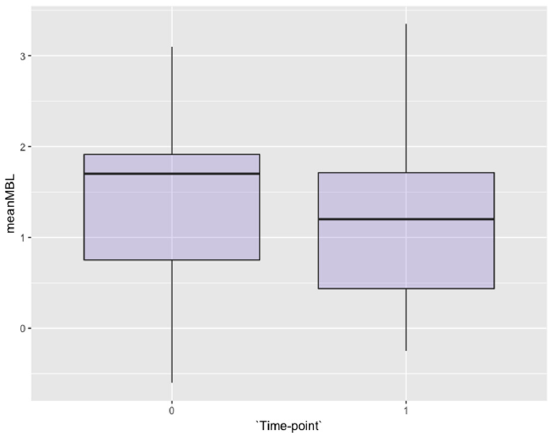
Figure 2. Box-plot of the mean marginal bone levels at the baseline and one year after loading. J. Clin. Med. 2019 , 8 , x FOR PEER REVIEW Table 2. Mean marginal bone level (MBL) in function by year, mm (per implant analysis) and statistical significance of time-effect according to the Behrens-Fisher test and the ANOVA results for implant-related factors.